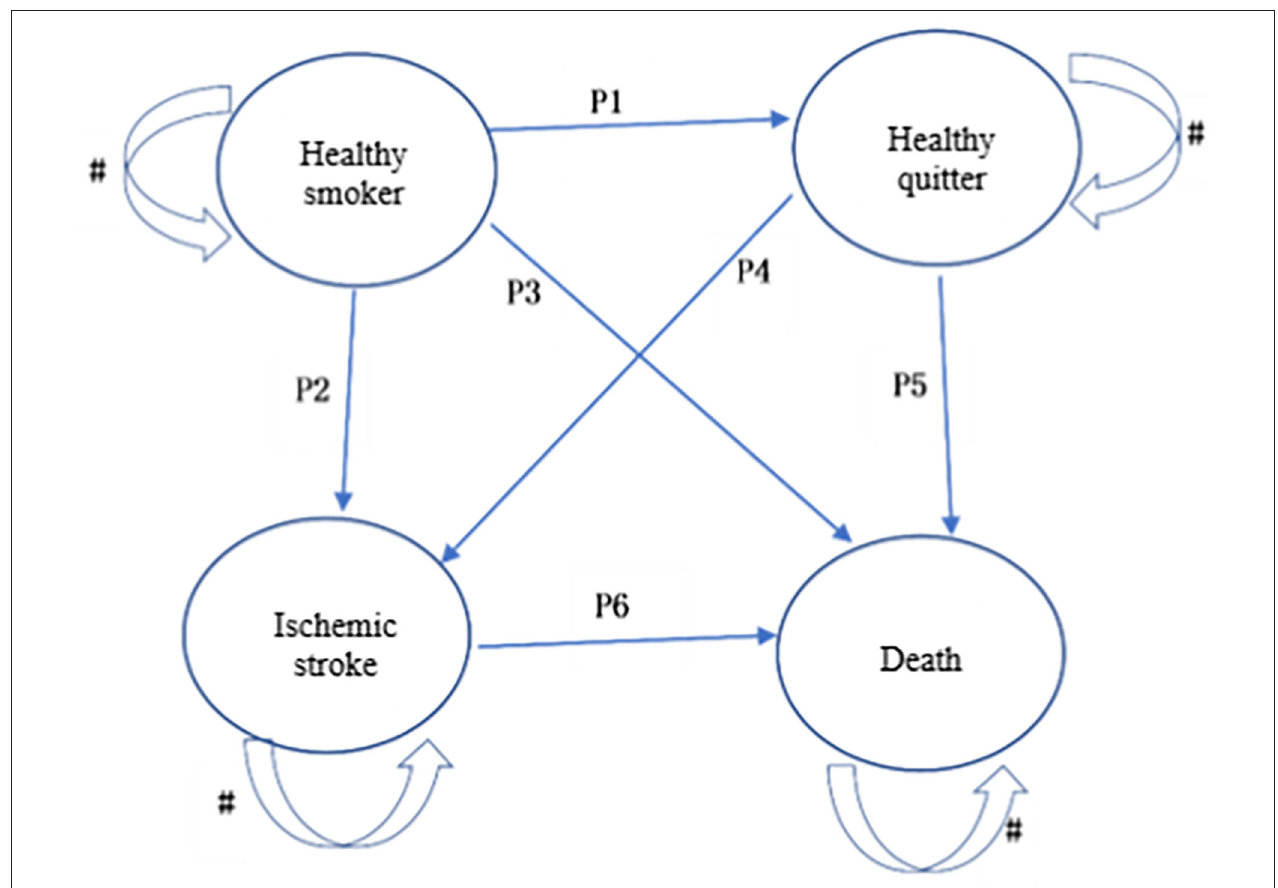
FIGURE 3 | Markov model structure. # indicates that there is a certain probability of remaining within the